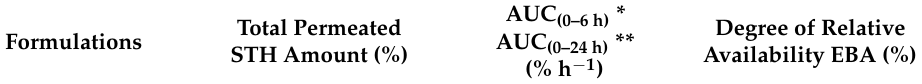
Table 2. Degree of STH permeation from hydrogels, area under the curve AUC (0–6 h) and relative availability of STH hydrogels without and with ALB when studying permeation through cellulose membrane and porcine